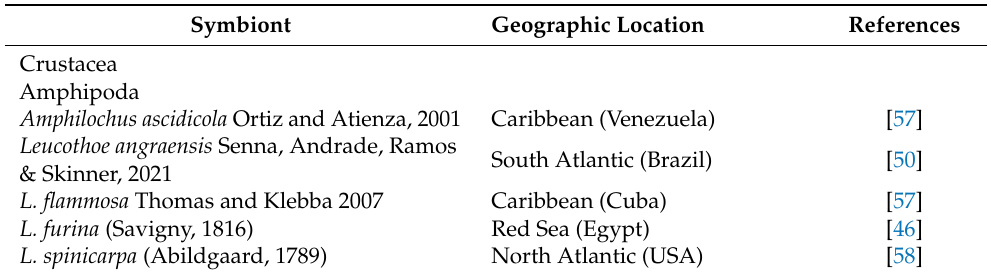
Table 1. Listing of all symbionts reported from the ascidian Phallusia nigra around the world. Symbiont Geographic